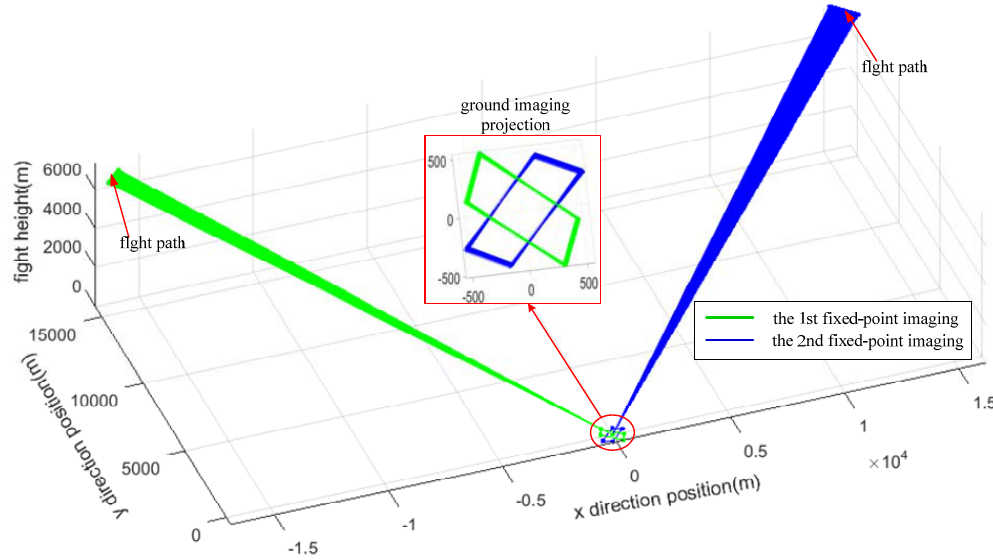
Figure 8. Aircraft flight path and ground imaging projection when the system performs fixed-point imaging in two different directions.